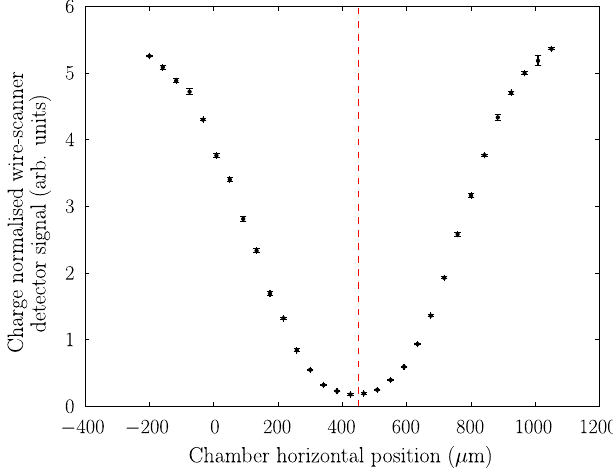
FIG. 15. Peak APD signal as a function of laser phase controlled by a 0 – 10 V static voltage. The red dashed line shows the chosen phase setting.